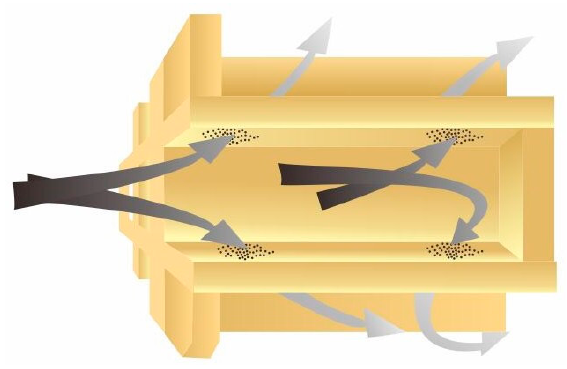
Figure 1. Schematic diagram of engine particulate filters structure.